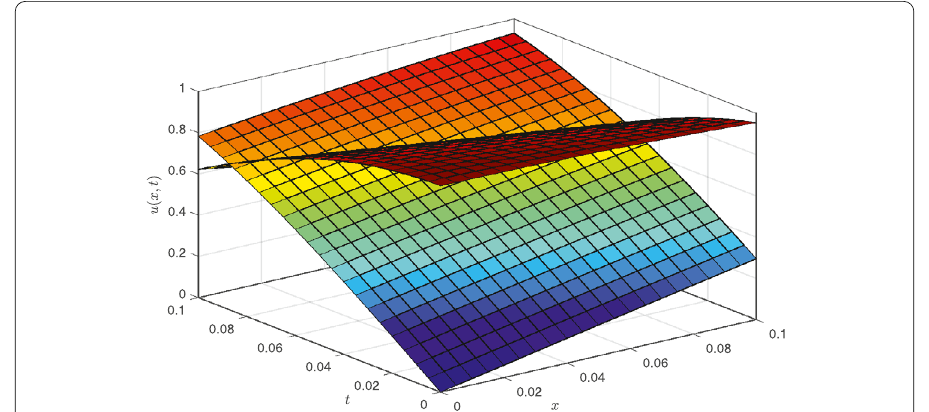
Figure 7 The approximate solution of Example 2 for Case 1 and α = β =